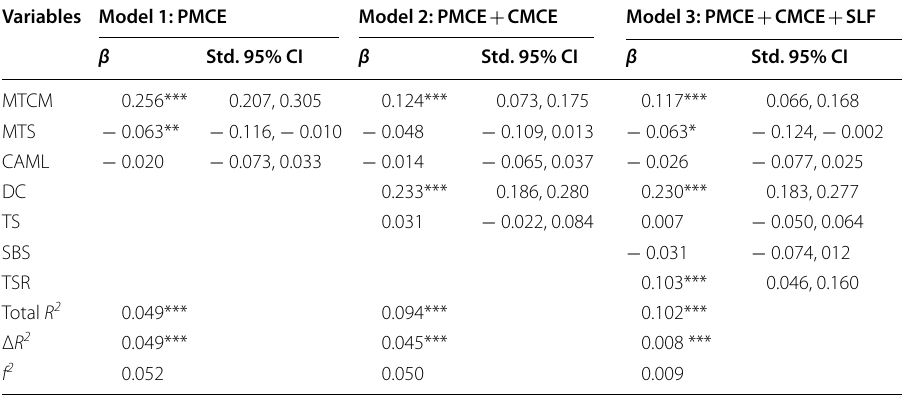
Table 3 School and Classroom Climate Contributions to Student Mathematics Achievement: Hierarchical Regression Model Results in the Aggregated